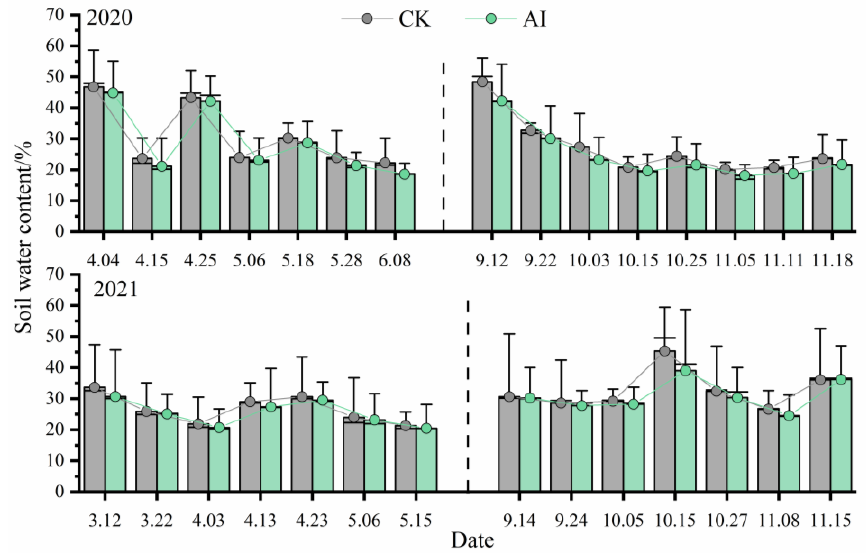
Figure 5. The dynamic change curve of soil water content under different treatments (AI, aerated irrigation; CK, unaerated subsurface drip irrigation).